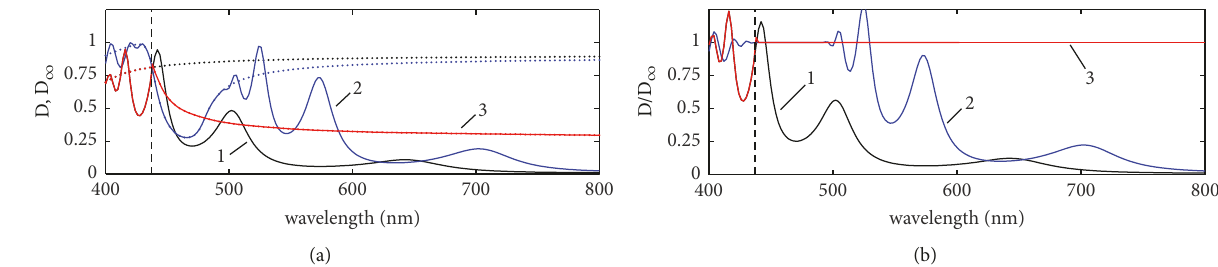
Figure 4: (Color online) (a) the absorption coefficient 𝐷 = 1 − |𝑅| 2 (solid lines) of the uniform MM layer of finite thickness 𝐿 𝑦 = 200 nm at normal incidence as a function of the wavelength. Dotted lines show the absorption coefficient 𝐷 ∞ = 1 − |𝑅 ∞ | 2 for the wave incident onto the metamaterial half-space. The orientation angle is 𝜙 = 0 (curve 1), 𝜙 = 0.1𝜋 (curve 2), and 𝜙 = 𝜙 ∗ (𝜆) (curve 3). (b) The ratio 𝐷/𝐷 ∞ for these three cases.